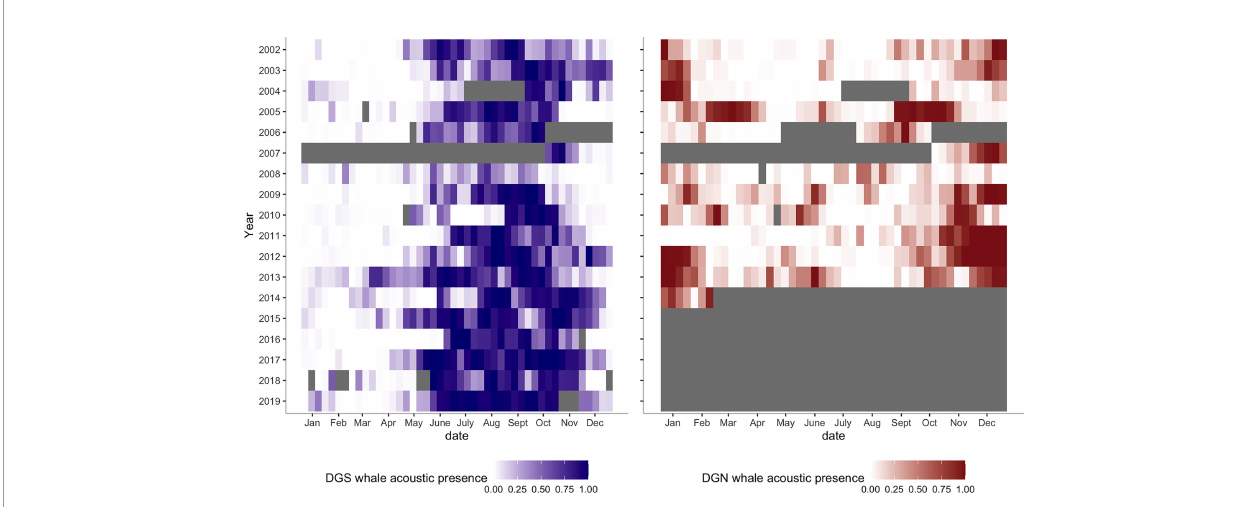
FIGURE 6 | Heatmaps of Chagos whale acoustic presence at DGS (left, blue colour, from 2002 to 2019) and at DGN (right, red colour, from 2002 to 2014). Grey bars are missing